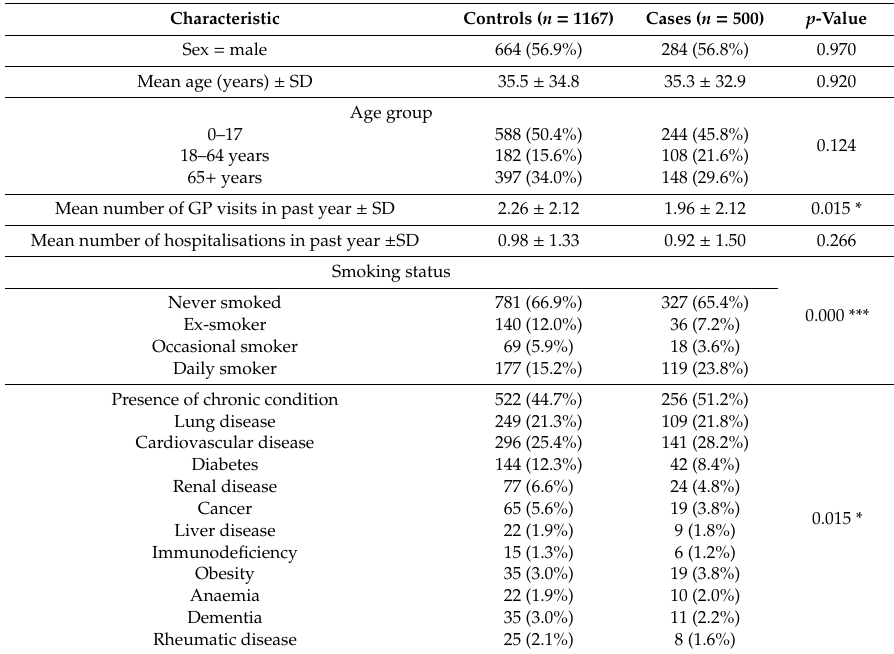
Table 1. Comparison of patient characteristics for cases and controls.